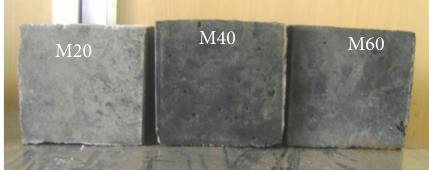
Figure 3: Geopolymer specimens exposed to 5% magnesium sulphate solution.